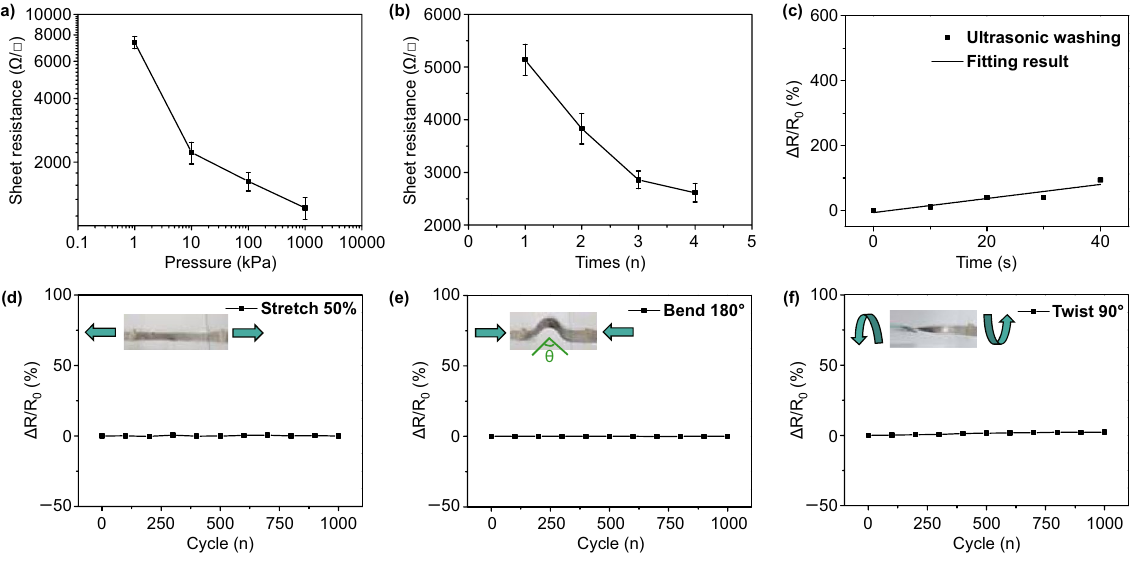
Fig. 2 Characterization of the electrical properties of CNT films. The sheet resistance of the transferred CNT films a at different stamp pressure, b at different stamp number of times. c The change of sheet resistance of the CNT film after ultrasonic washing at different time. Electric stabil- ity of CNT film d during 1000 cycles stretching under strain of 50%, e during 1000 cycles under bending (180 degrees), f during 1000 cycles twisting (90